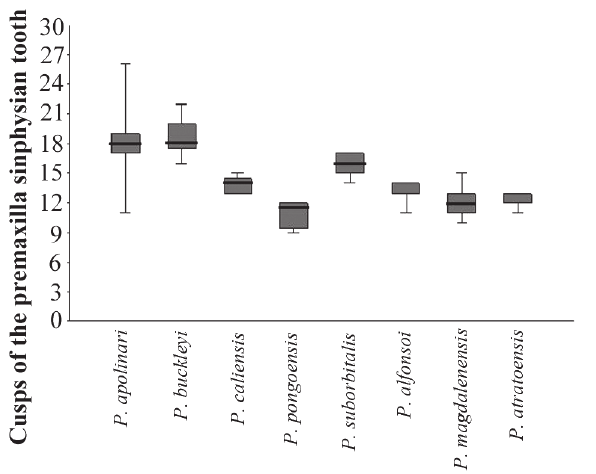
Fig. 13. Number of cusps present on premaxillary tooth at symphysis of Colombian species of